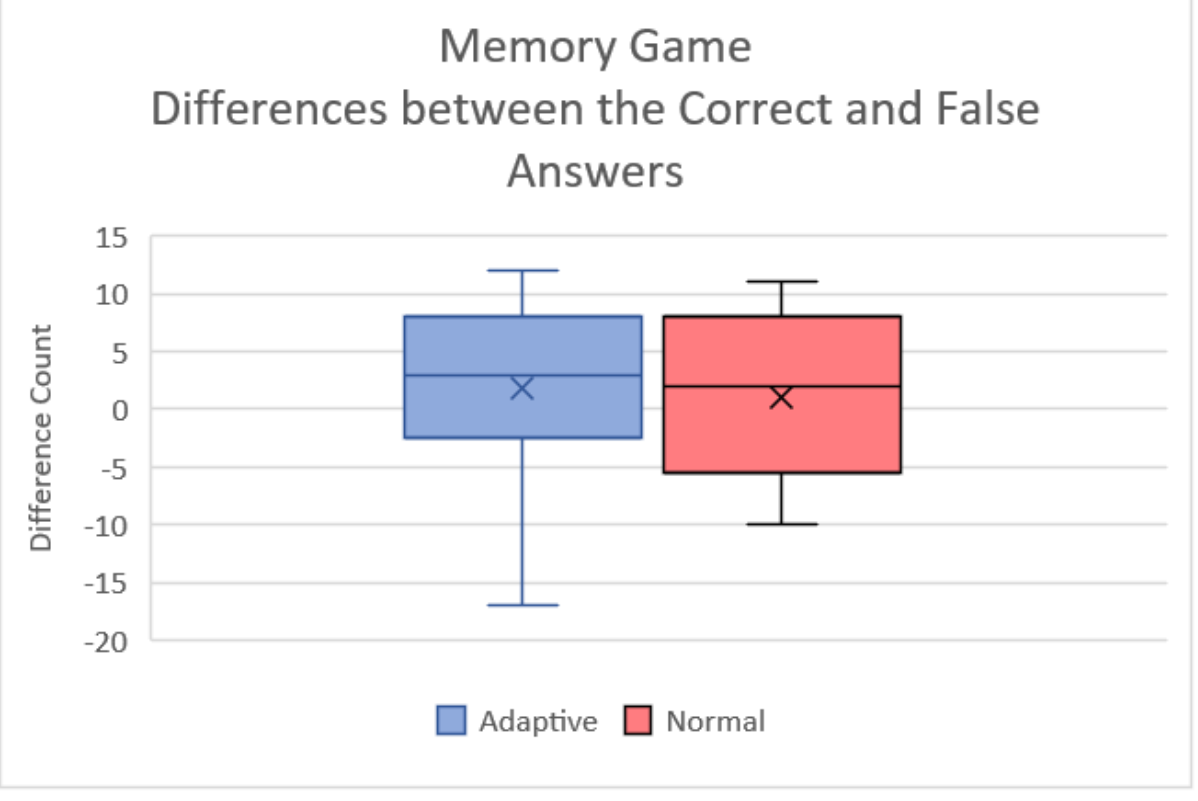
Figure 11. Box plot of the difference between the correct and false answers for the Memory game from the second session with students.